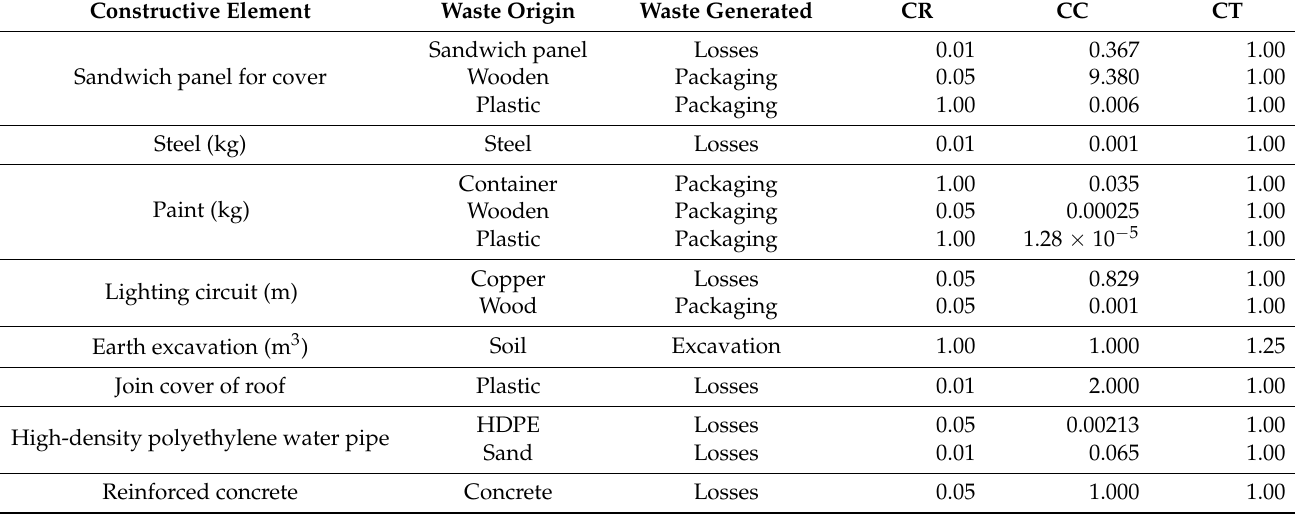
Table 2. Transformation coefficients for an industrial building construction (examples defined in the present